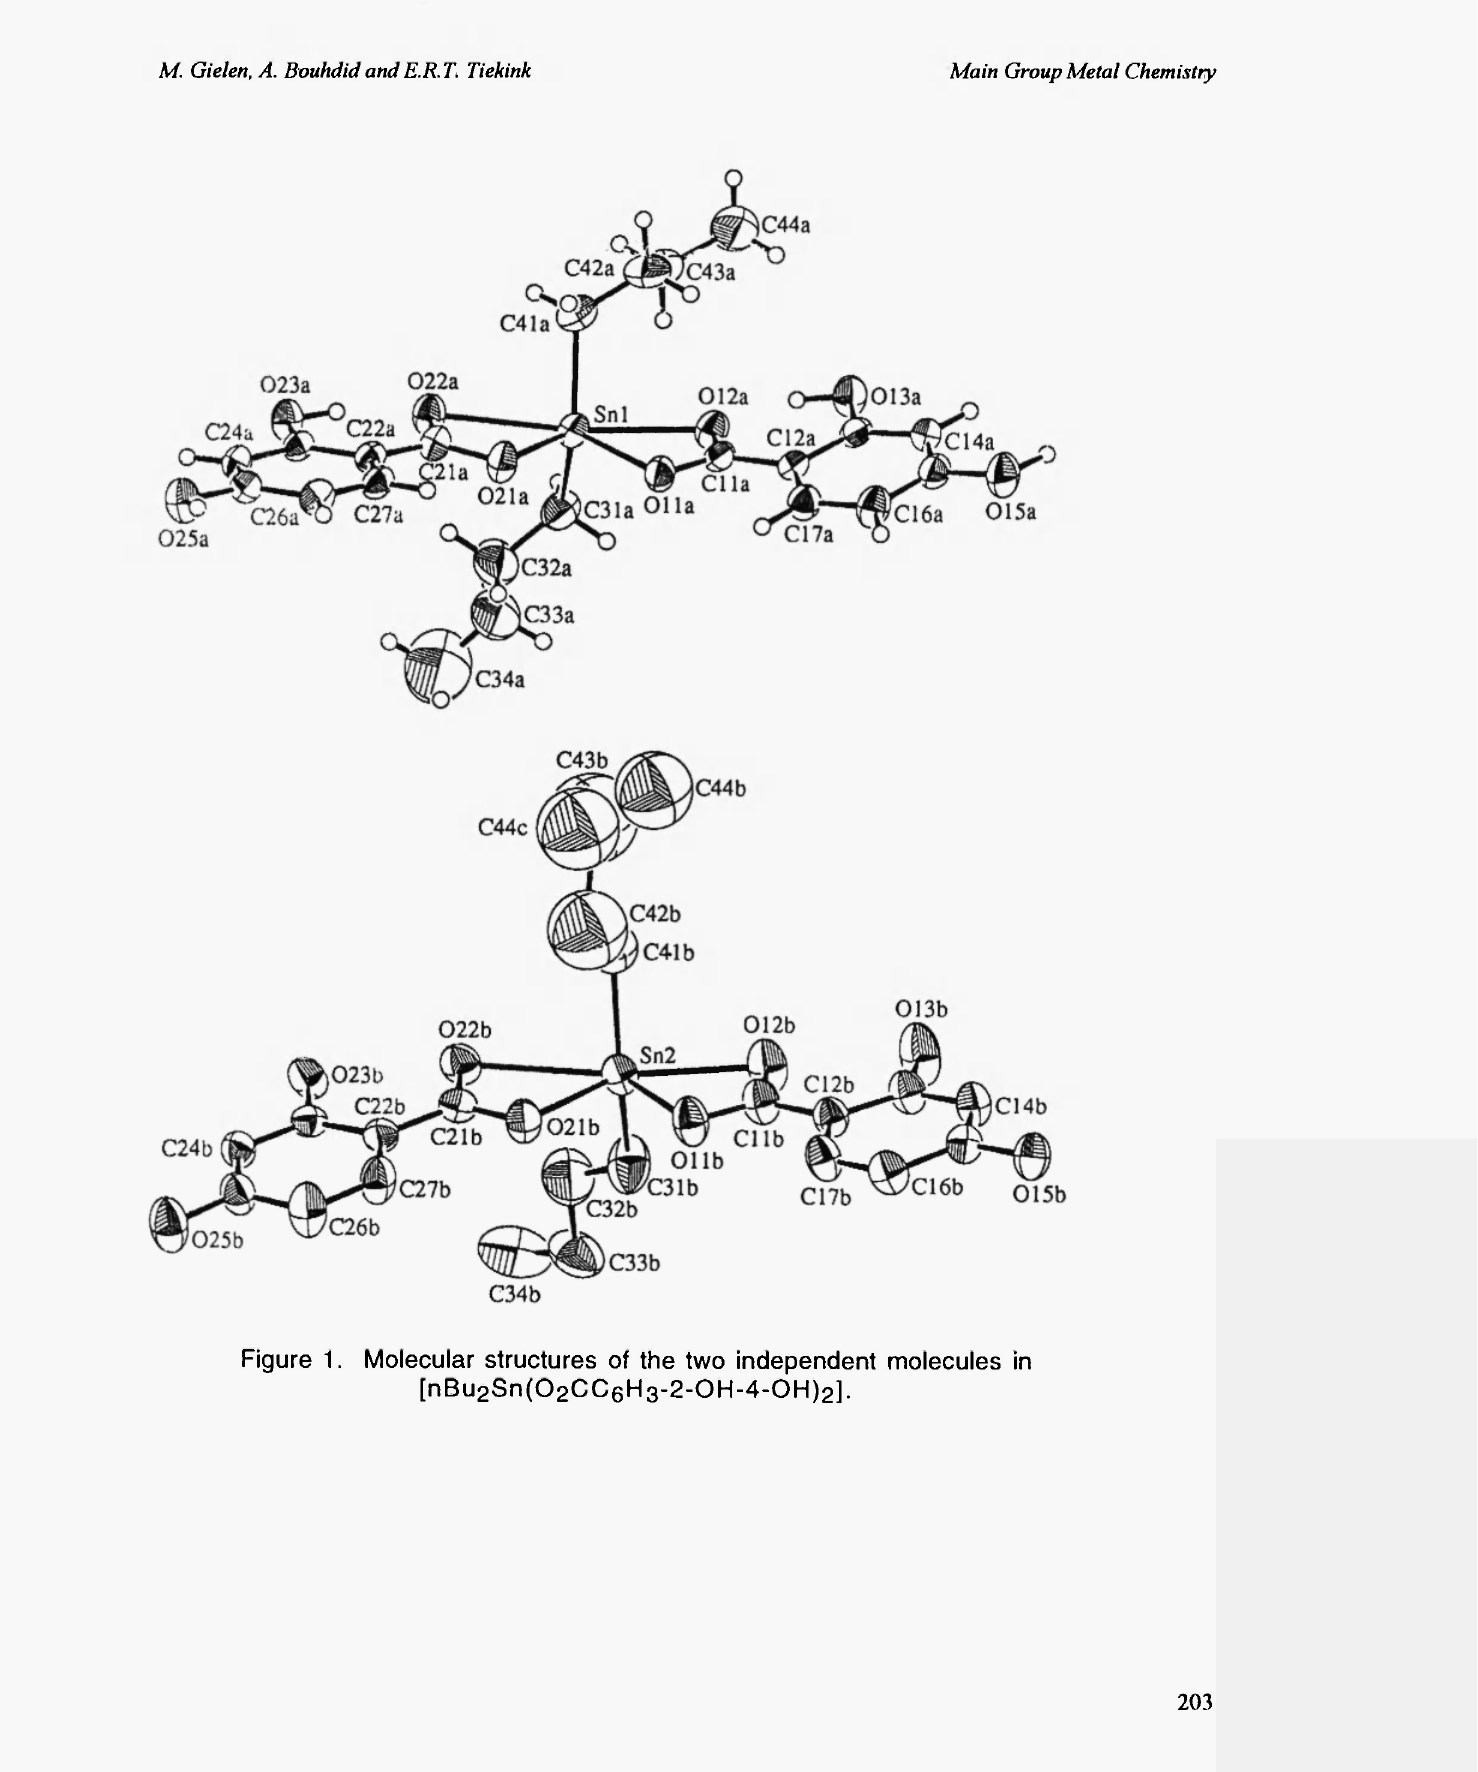
Figure 1. Molecular structures of the two independent molecules